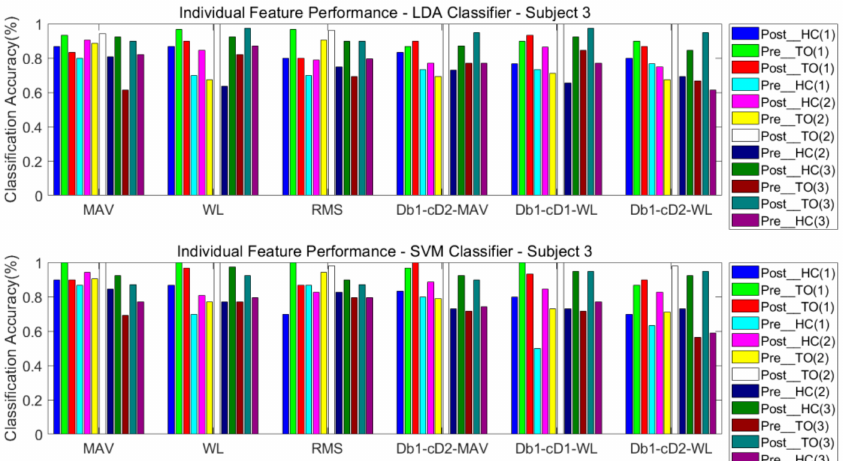
Figure 10. Classification performance of individual sEMG features; Subject #3.